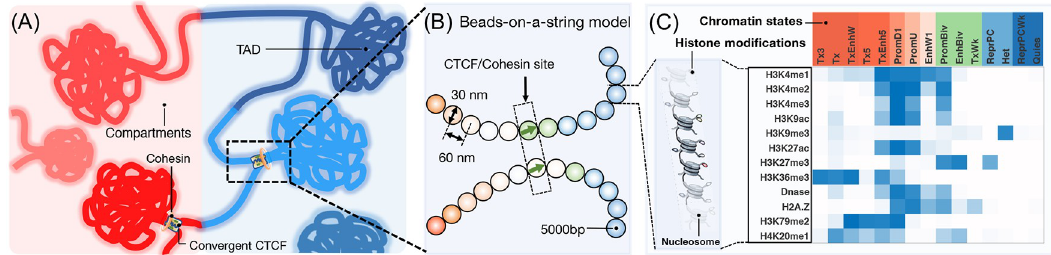
Fig 1. Overview of the key elements of the computational model. (A) Illustration of genome organization at various length scales that includes the formation of CTCF mediated chromatin loops, TADs, and compartments. (B) A schematic representation of the computational model that highlights the assignment of chromatin states and CTCF binding sites. Chromatin states for each bead—a 5kb long genomic segment—are derived from the combinatorial patterns of histone marks. They are shown in part (C) as a heat map with darker colors indicating higher probabilities of observing various